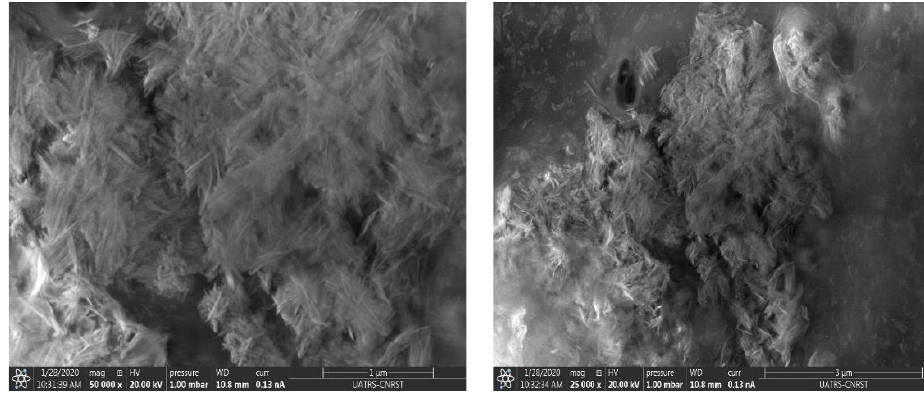
Figure 4. SEM images of HAp/CTs composite.